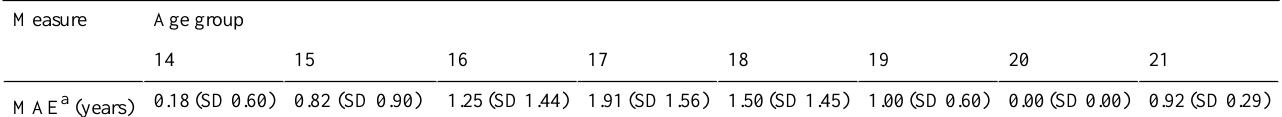
Table 12. Mean absolute error and SD for the average male